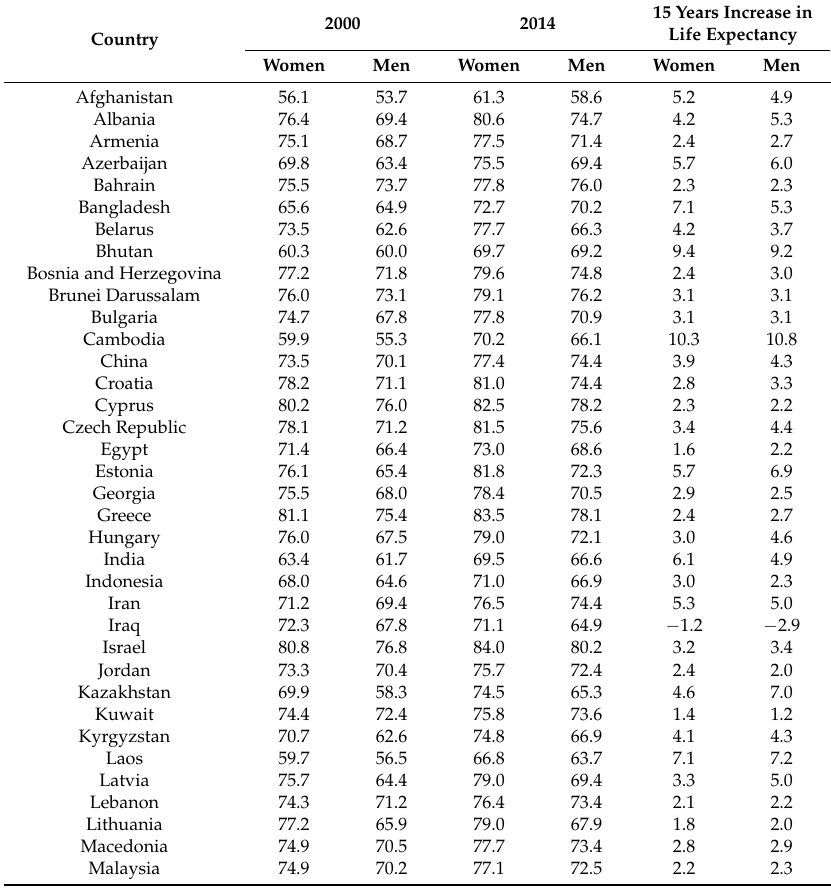
Total life expectancy in the same year was weighted by the population size. Table 2. Change of life expectancy years in 65 Belt and Road countries,